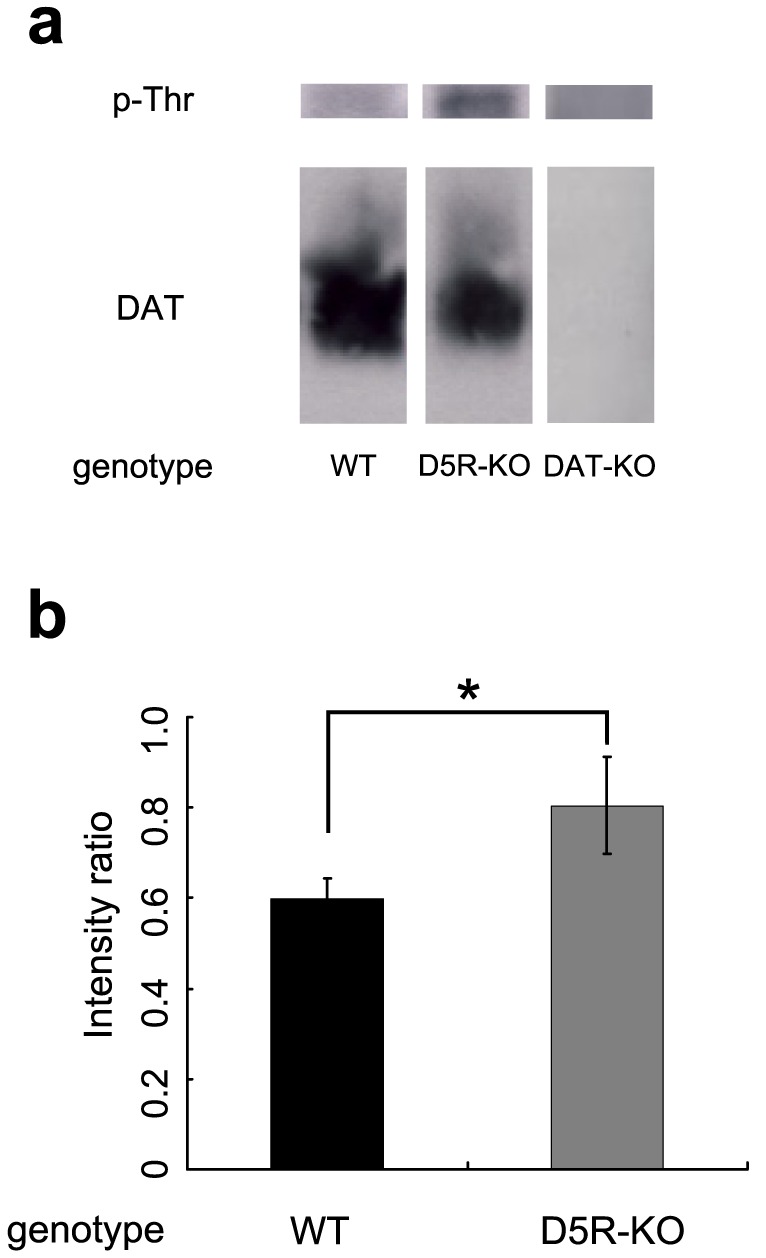
DAT phosphorylation in D5R-KO mice.DAT proteins were immunoprecipitated from whole brain lysates and were then immunoblotted with anti-phosphothreonine and anti-DAT antibodies. (a) Upper: Representative Western blot of phospho-threonine signals of immunoprecipitated DAT proteins. Lower: Total DAT protein levels of the same samples. WT, D5R-KO, and DAT-KO genotypes are indicated. (b) The intensities of the phosphothreonine bands were normalized to the intensities of the total DAT protein bands to quantify the phosphothreonine levels. WT mice, black bar; D5R-KO mice, gray bar. Threonine phosphorylation levels were significantly increased in D5R-KO mouse brains relative to WT mouse brains. Paired t-test: t = −2.59 and p<0.05. * p<0.05.